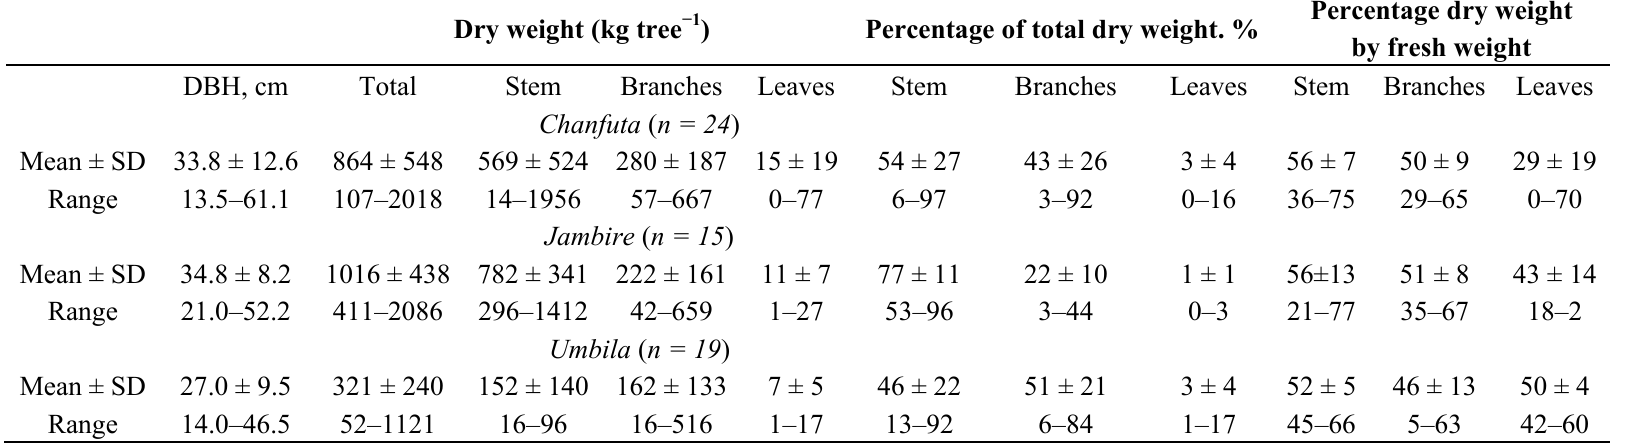
Table 4. Dry weight of tree components and their proportional